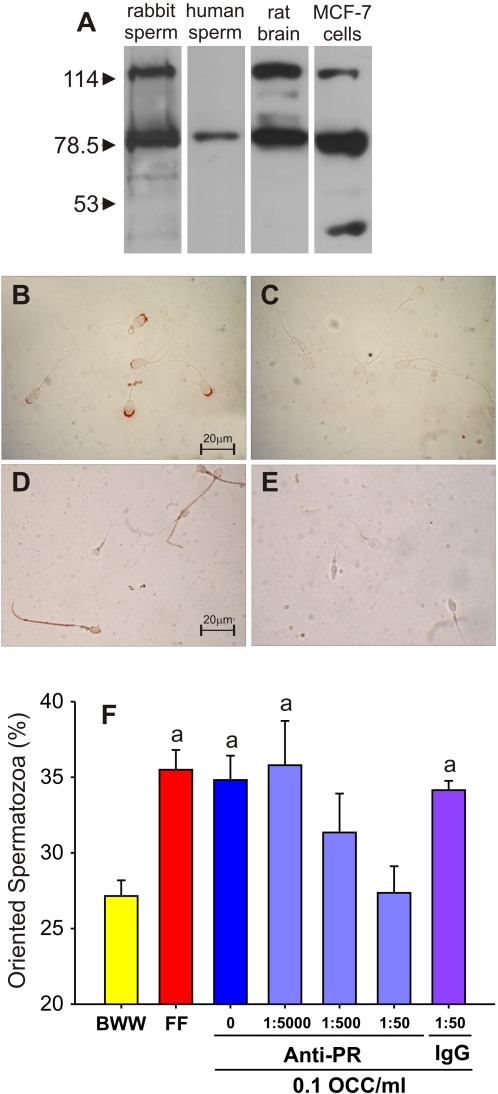
A cell surface P receptor is involved in the sperm chemotactic response.A, western blot with an anti-P receptor antibody in rabbit and human spermatozoa; rat brain and MCF-7 cell line lysates were carried out as positive controls. Three experiments were carried out. B–E, cell surface P receptor localization in non permeabilized spermatozoa by immunocytochemistry with an anti-P receptor antibody. The P receptor is localized over the acrosomal region in rabbit spermatozoa (B), and also in the tail of human spermatozoa (D); C and E are the respective negative controls in the absence of anti-P receptor antibody. F, Percentage of oriented spermatozoa towards the OCC conditioned medium (0.1 OCC/ml) previously incubated with anti-P receptor antibody (Anti-PR), whereas the incubation with an unrelated antibody (IgG) was assayed as negative control. The sperm capacitation medium (BWW) and 1∶104 bovine FF were assayed as negative and positive chemotaxis controls, respectively. Four to five experiments were carried out, giving a total of 600–750 analyzed spermatozoa per treatment. Data are expressed as mean±SE. a Significant differences vs. BWW (p<0.05).